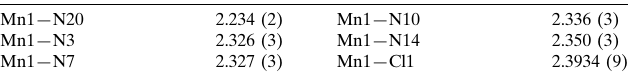
Selected bond lengths (A˚ ).